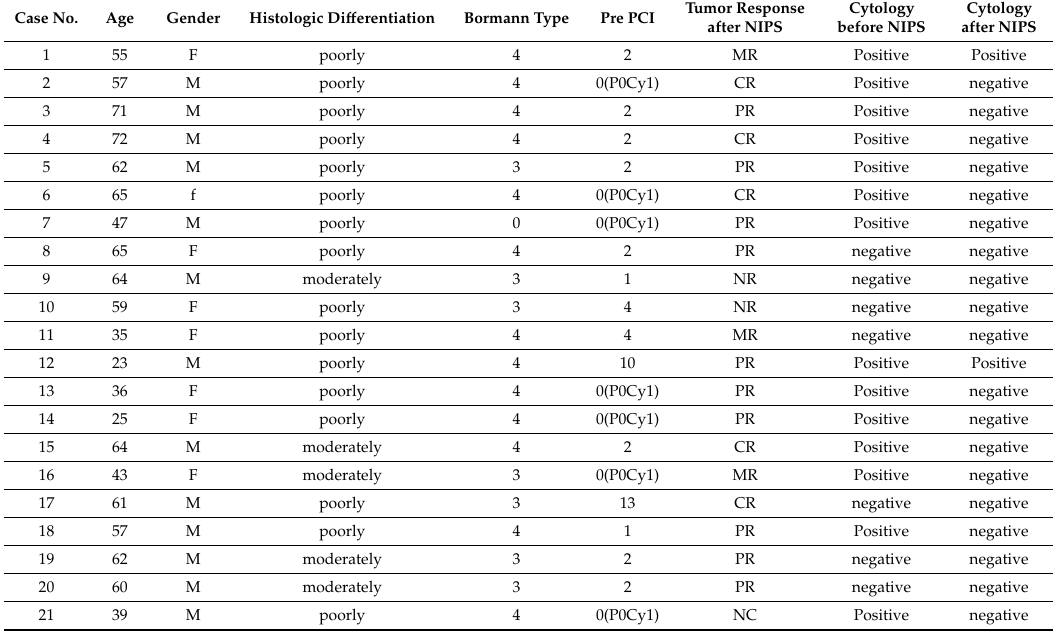
Table4. Clinicaldata, PeritonealCancerIndexbeforeNIPS(pre-PCI),histologicalresponsesofperitoneal metastasis after NIPS and cytology status before and after NIPS in 21 patients with 5-year survival. Case No. Age Gender Histologic Di ff